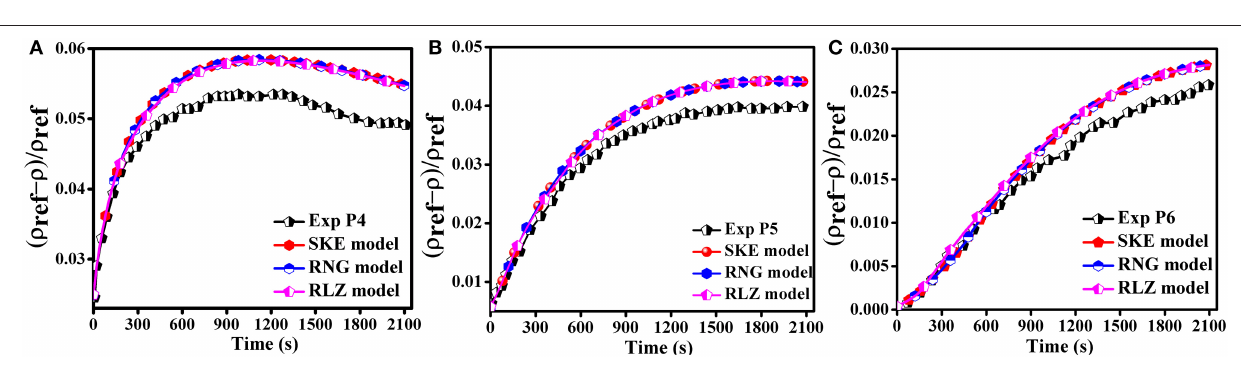
FIGURE 4 | Effect of air-injection velocity 0.411 m/s on the simulation results for monitors (A) P4, (B) P5, and (C) P6.